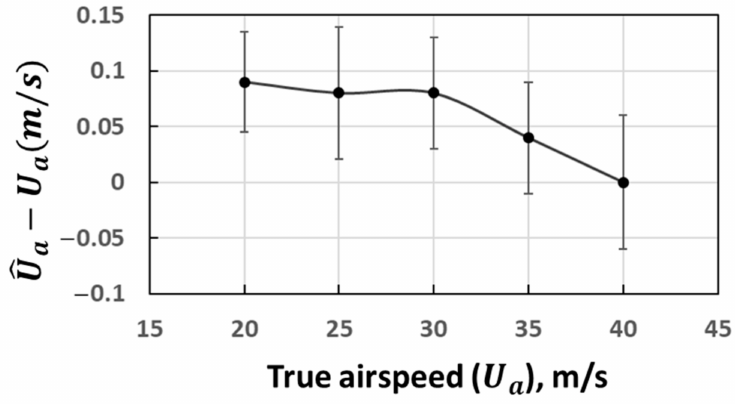
Figure 7. Wind tunnel test error curve for true airspeed, where the y axis is the difference between the measured and actual true airspeeds. For clarity, mean values with SD are shown in lieu of all